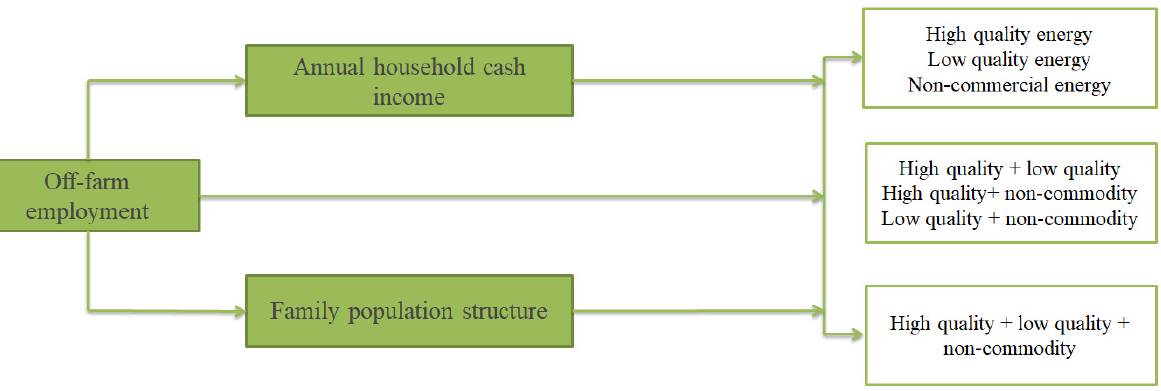
Figure 1. Conceptual framework .